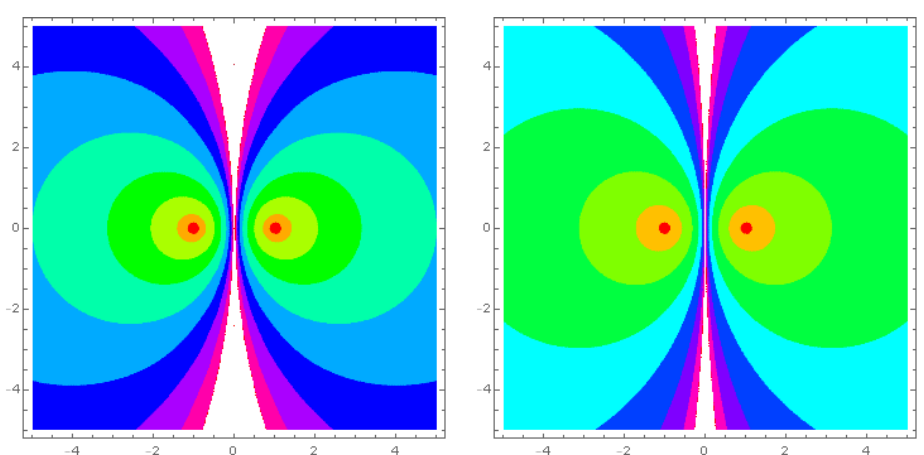
Figure 1. Attraction basins on f ( z ) = z 2 − 1 for the secant; Newton solvers on left, and right, respectively.